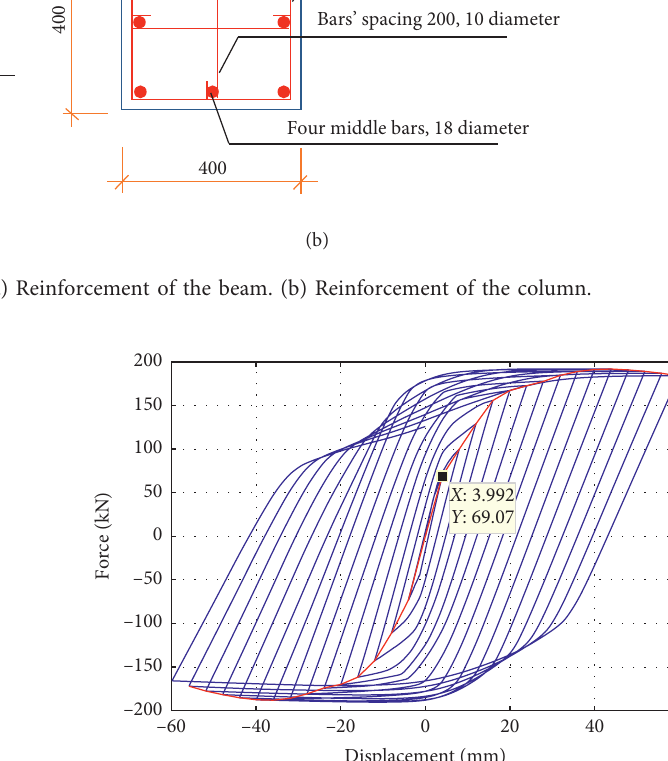
Figure 4: YLP100 stress-strain curve.